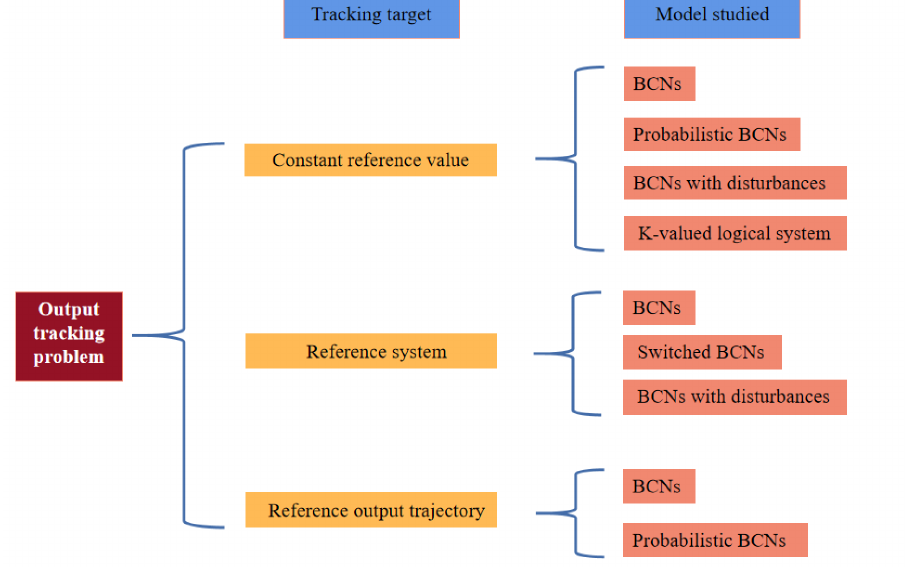
Figure 1. Research status of output tracking